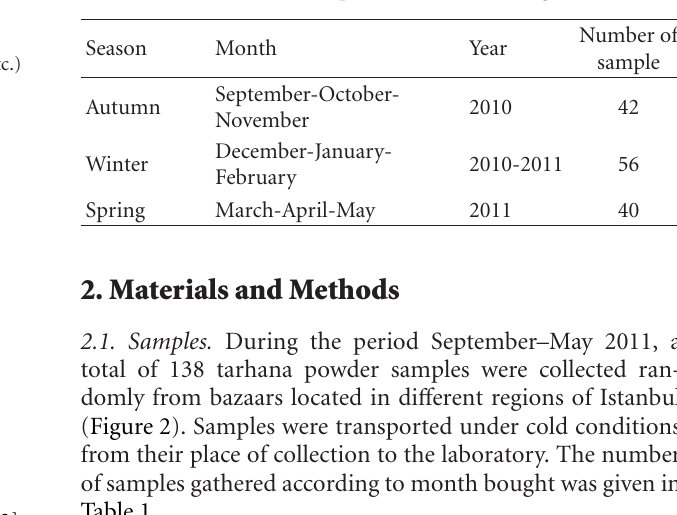
Figure 1: Flow diagram for traditional tarhana production [12].